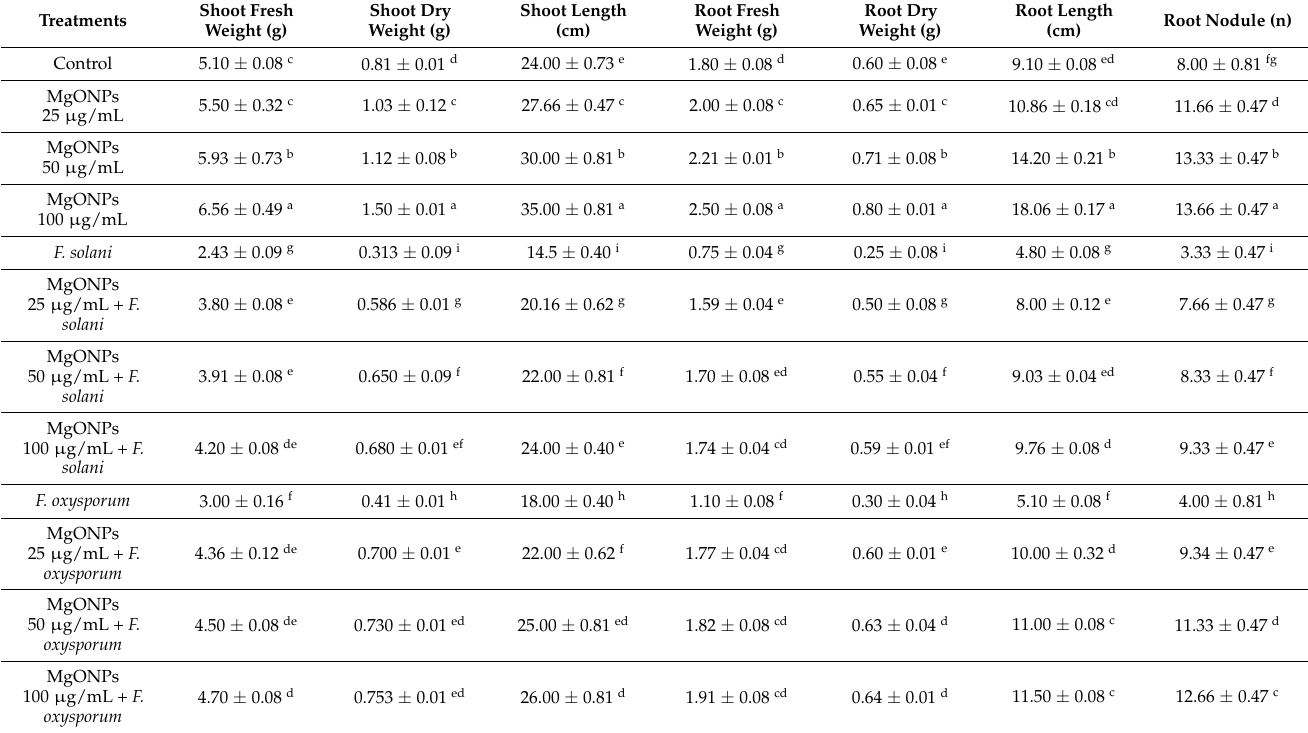
Table 1. The impact of MgONPs on the shoot fresh weight, shoot dry weight, shoot length root fresh weight, root dry weight, root length, and the number of root nodules of mung bean seedlings.